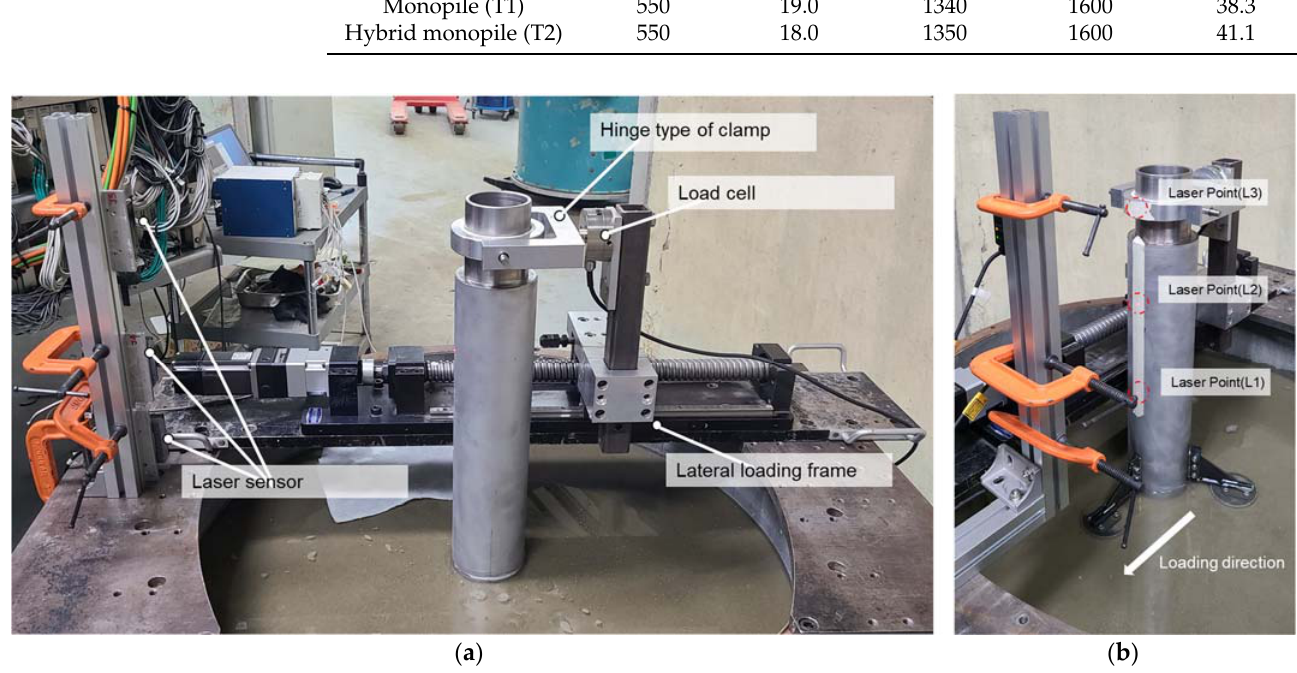
Figure 5. Loading system: ( a ) main components; ( b ) laser senor measurement.